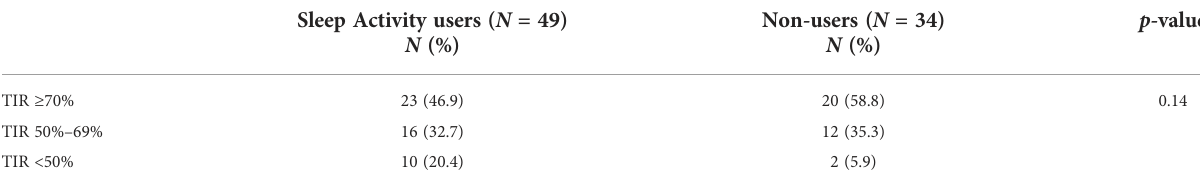
TABLE 3 Comparison by category of nighttime TIR between Sleep Activity Mode users (group 1) and non-users (group 2); analysis included patients using sensor and automatic mode ≥ 80% ( N = 83). Sleep Activity users ( N = 49)